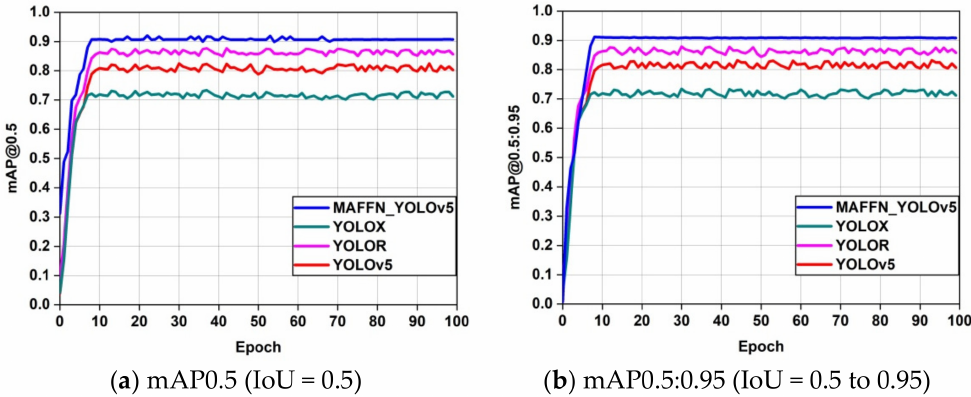
Figure 20. Performance comparison of the mean Average Precision (mAP) value of MAFFN_YOLOv5, YOLOR, YOLOX, and YOLOv5 models.